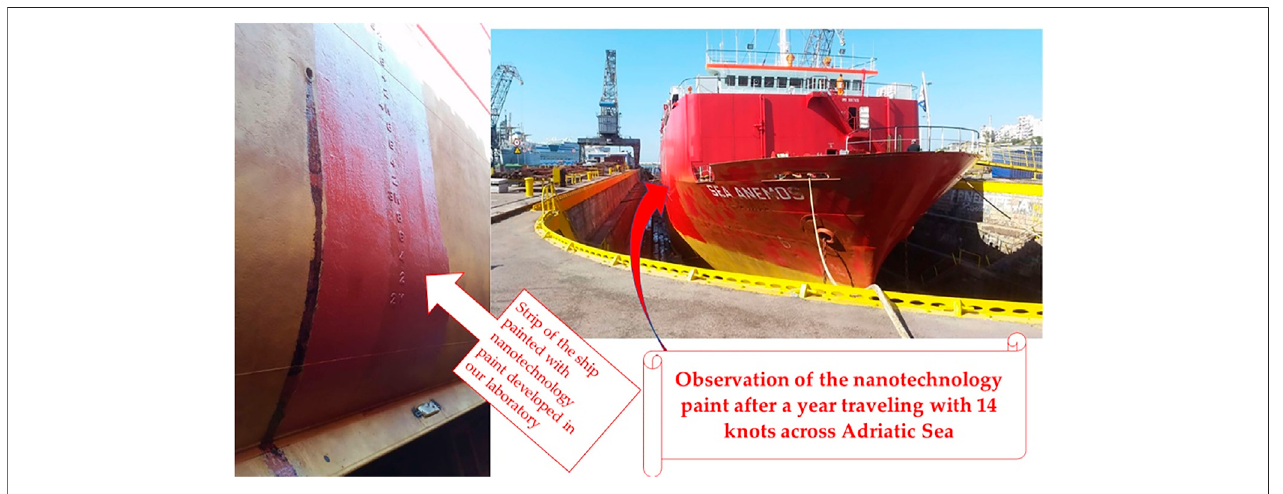
FIGURE 4 | Result of the nanocontainer-based paint exposed to